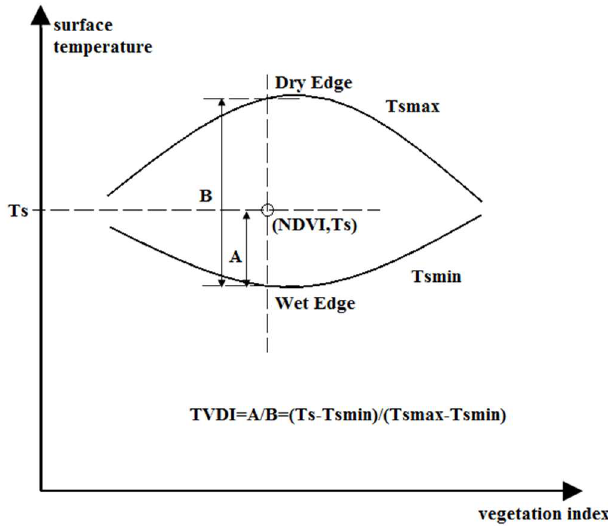
Figure 3. Sketch map of TVDI in bi-parabolic NDVI-T s space.